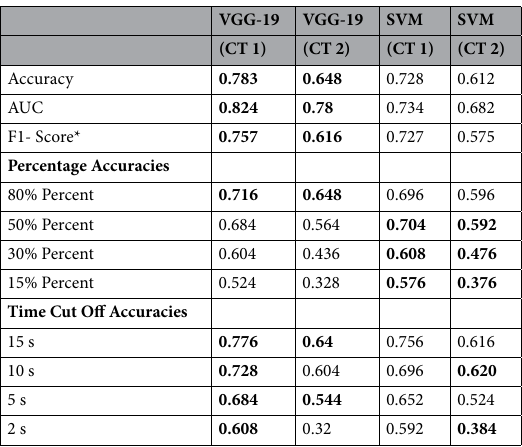
Table 1. Performance results of image classifiers on test set. * For Classification Task 2, weighted average metrics are reported. Total number of test observations = 250. The best result of each trial is highlighted in